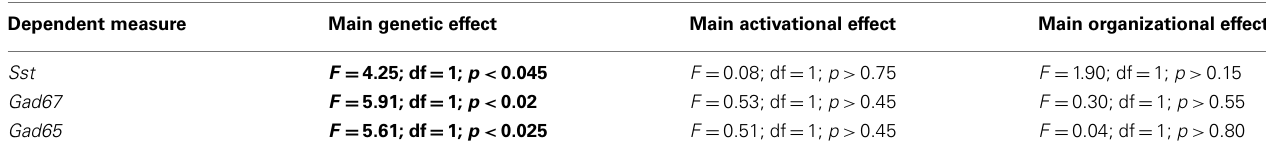
TableA1 | Statistical values associated Sst , Gad67 , and Gad65 gene expression in the frontal cortex of FCG mice.